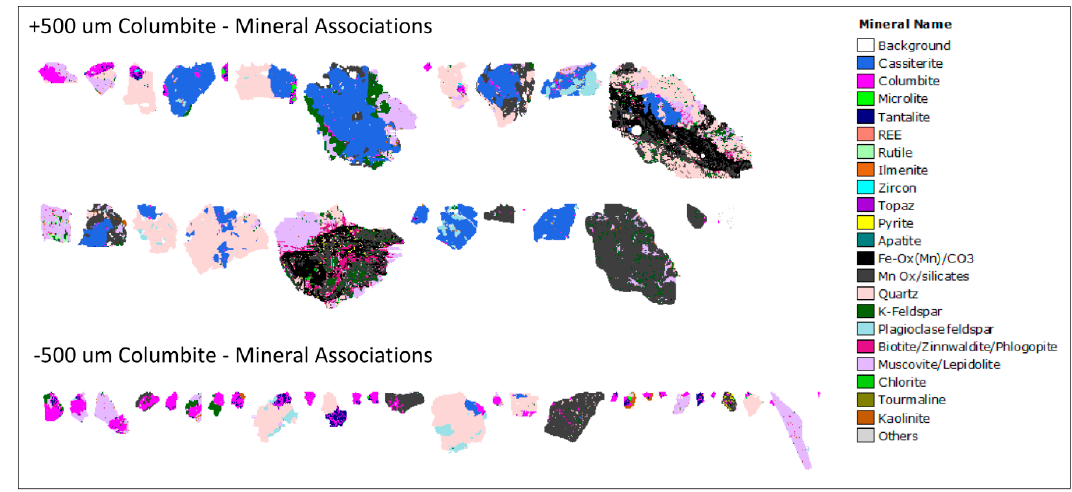
Figure 8. QEMSCAN false colour image of Columbite-group and associated minerals.